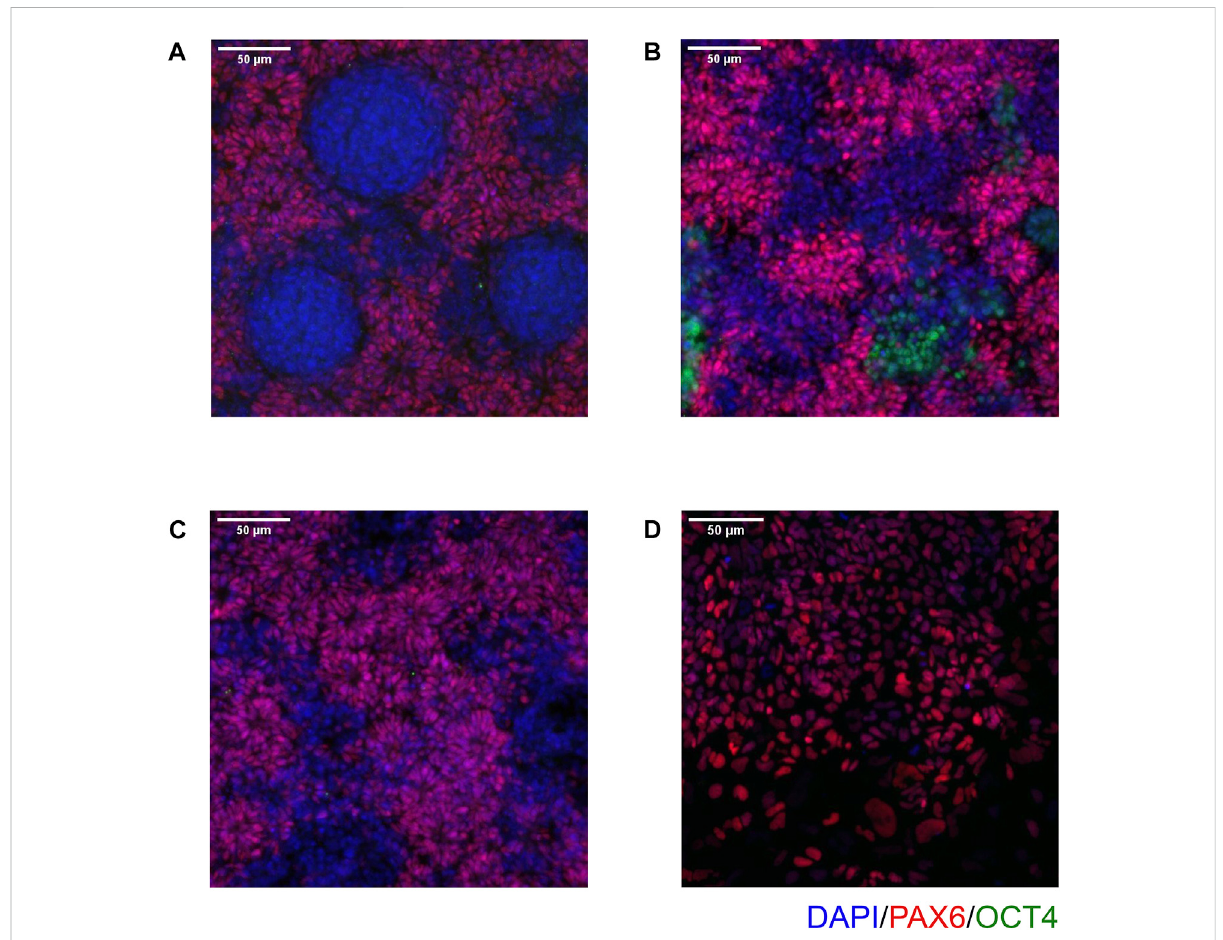
FIGURE 6 Examplesofcommonissuesseeninimmunocytochemistry. (A) CircularclumpsofcellsthatdonotexpressPAX6,surroundedbyPAX6-positive cells. (B) PatchyPAX6expression,withareasalsoexpressingOCT4. (C) Similarto (B) ,PatchyPAX6expression,howeverinthiscasethemorphologyis still good with obvious neural rosettes. (D) NSCs have failed to properly attach to the 96 well plate and so do not take on the expected morphology. Scale bar, 50 μ m